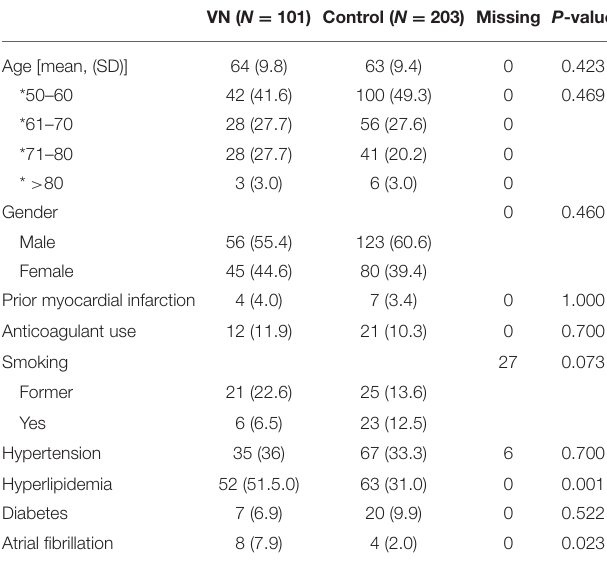
TABLE 1 | Patient characteristics.